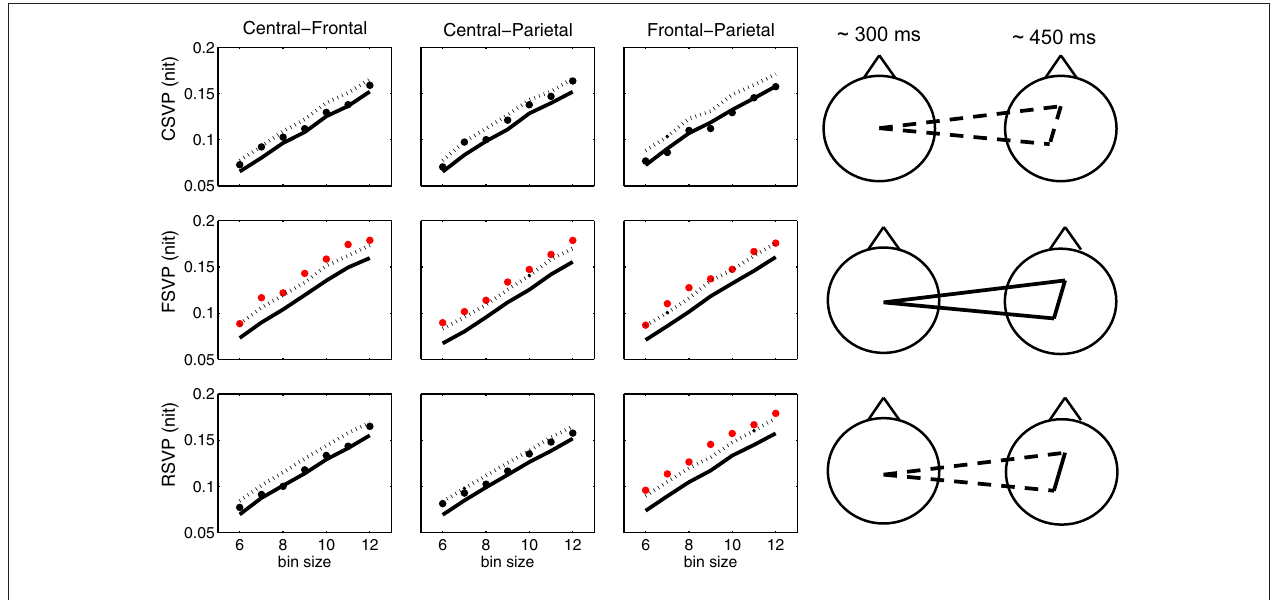
FIGURE 7 | Functional connectivity between electrode clusters assessed via mutual information analysis. Left: The dashed lines show the upper bound of the 95% confi dence interval of the group average mutual information computed from a bootstrap procedure (1000 bootstrap samples). The dots show the actual group average mutual information (in nit) for the three pairs of clusters with the number of bins from 6 to 12. The mutual information is considered signifi cant (marked by red) if the dot is above the dashed line. The solid lines show the mean